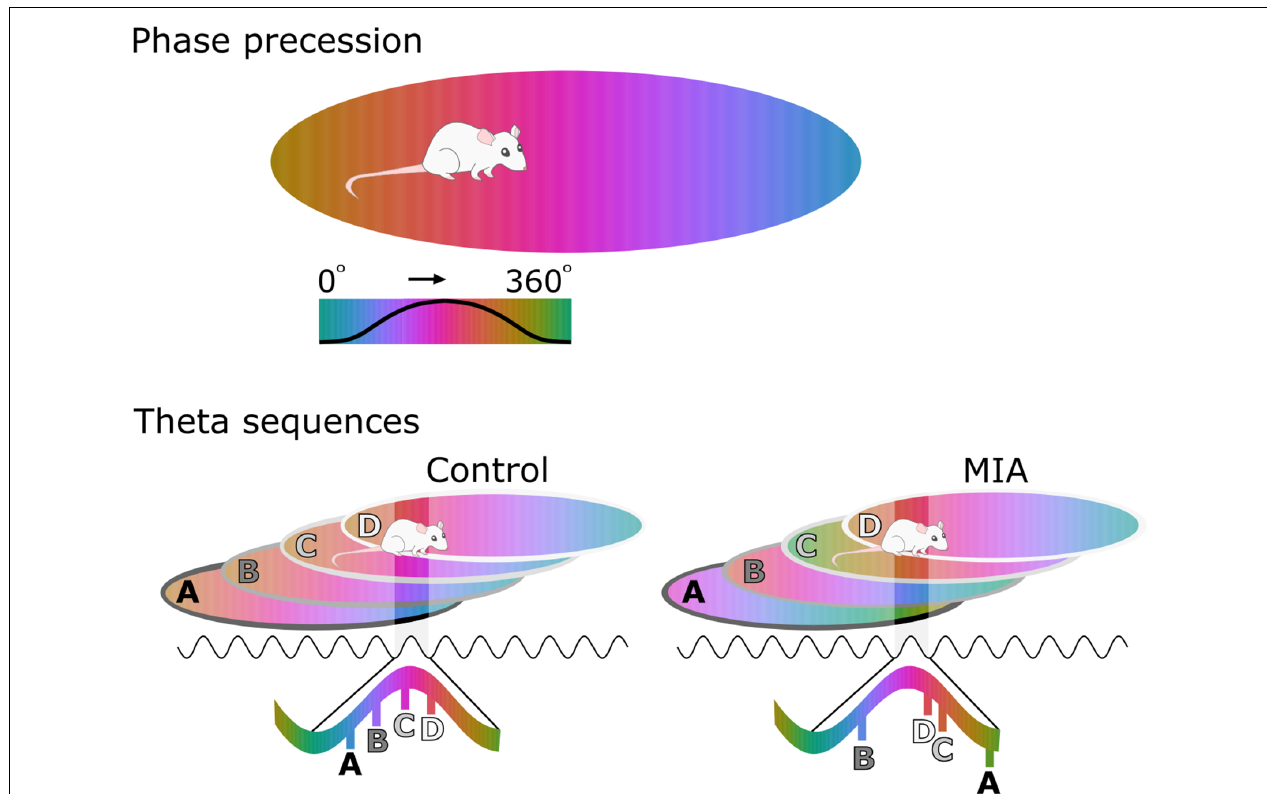
FIGURE 1 | Disorganized phase coding of hippocampal place cells produces disordered theta sequences in maternal immune activation (MIA) animals. The upper cartoon illustrates phase coding occurring as an animal crosses a place field, with phase color-coded. As the animal enters the place field, the cell spikes at late phases of the theta cycle, but spiking processes towards earlier phases as the animal traverses the field. The lower cartoon demonstrates how theta sequences emerge as a result of phase precession in several cells with overlapping place fields. In the control example, the starting phase of precession is coordinated at the network level, resulting in ordered theta sequences that are concentrated along a portion of a theta cycle. Here cell A fires first during the theta cycle because the animal is exiting this place field. In contrast Cell D fires last, because the animal is entering this field. In the MIA example, starting phase varies from cell to cell, resulting in disordered sequences that are also spread further across the theta